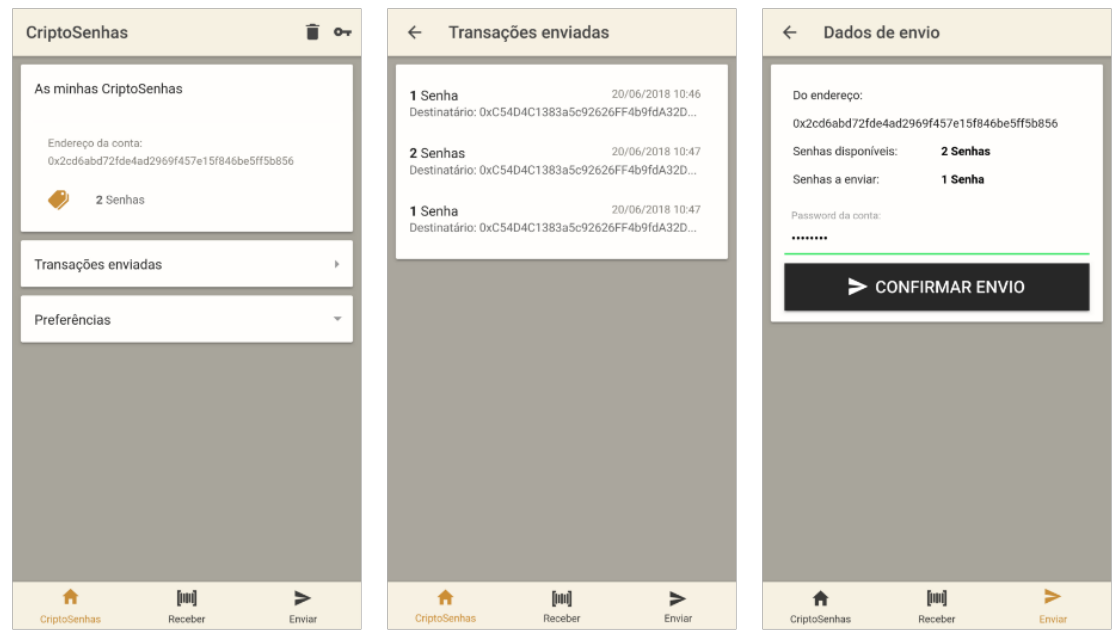
Figure 19. Results of some of the views of the CriptoSenhas application.